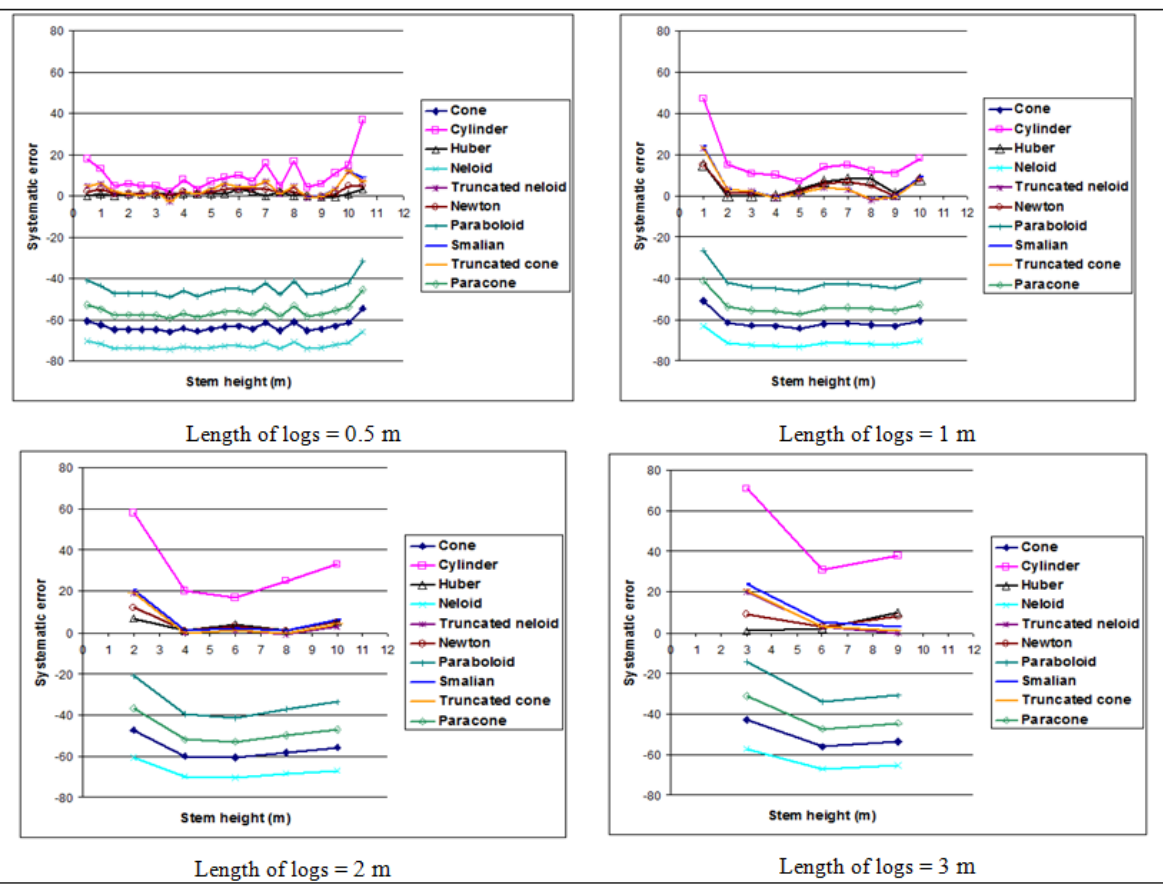
Figure 3. Trend of the systematic error along the stem.